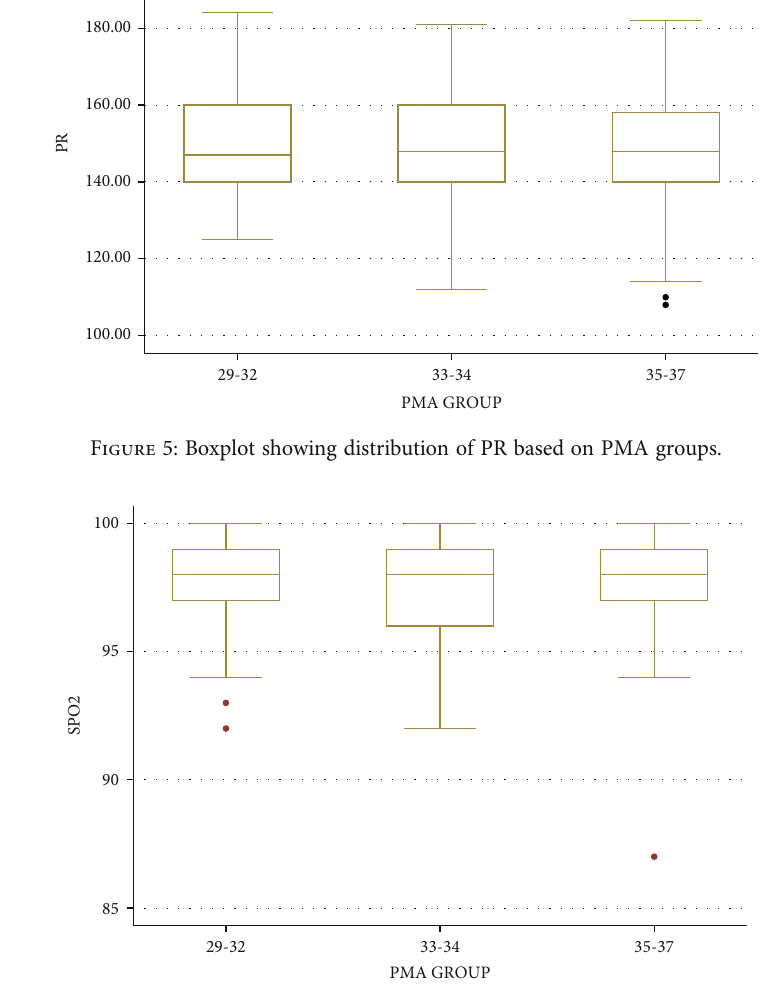
Figure 6: Boxplot showing distribution of SPO2 based on PMA